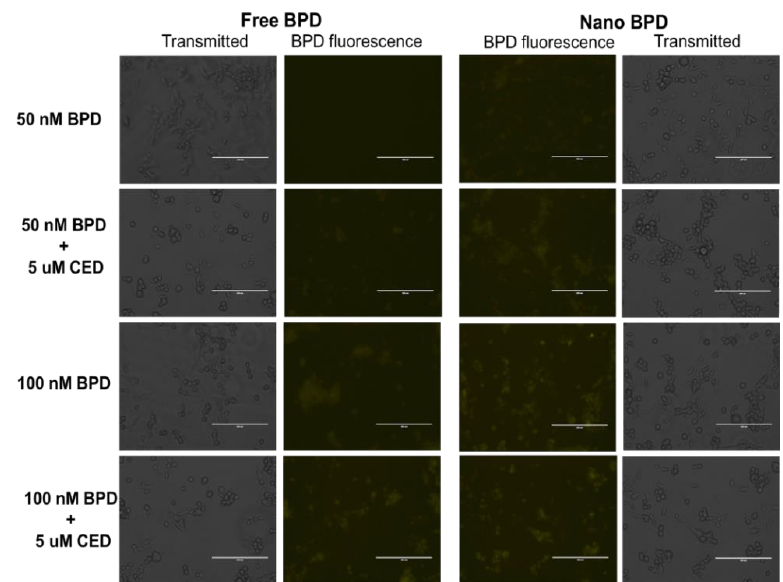
Figure 6. Imaging Study results for free ( left side ) versus NP ( right side ) formulations of BPD using various concentrations of 50 and 100 nM BPD to assess fluorescence in U87 cells. Cells were also treated with CED in certain treatment groups to assess the influence of CED on BPD fluorescence. Images were taken at 20× magnification at 60% light intensity (Cy5 filter) for each image shown above. An increase in fluorescence is seen in the NP BPD form compared to the free drug, while the incidence of CED does not appear to inhibit BPD fluorescence. Scale Bar: 200 µm.